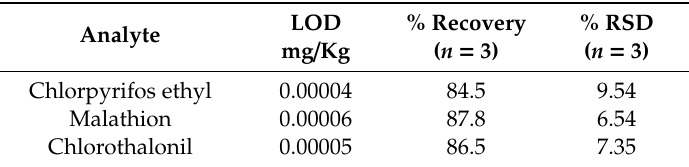
Table 4. Summary of the evaluated analytical parameters.